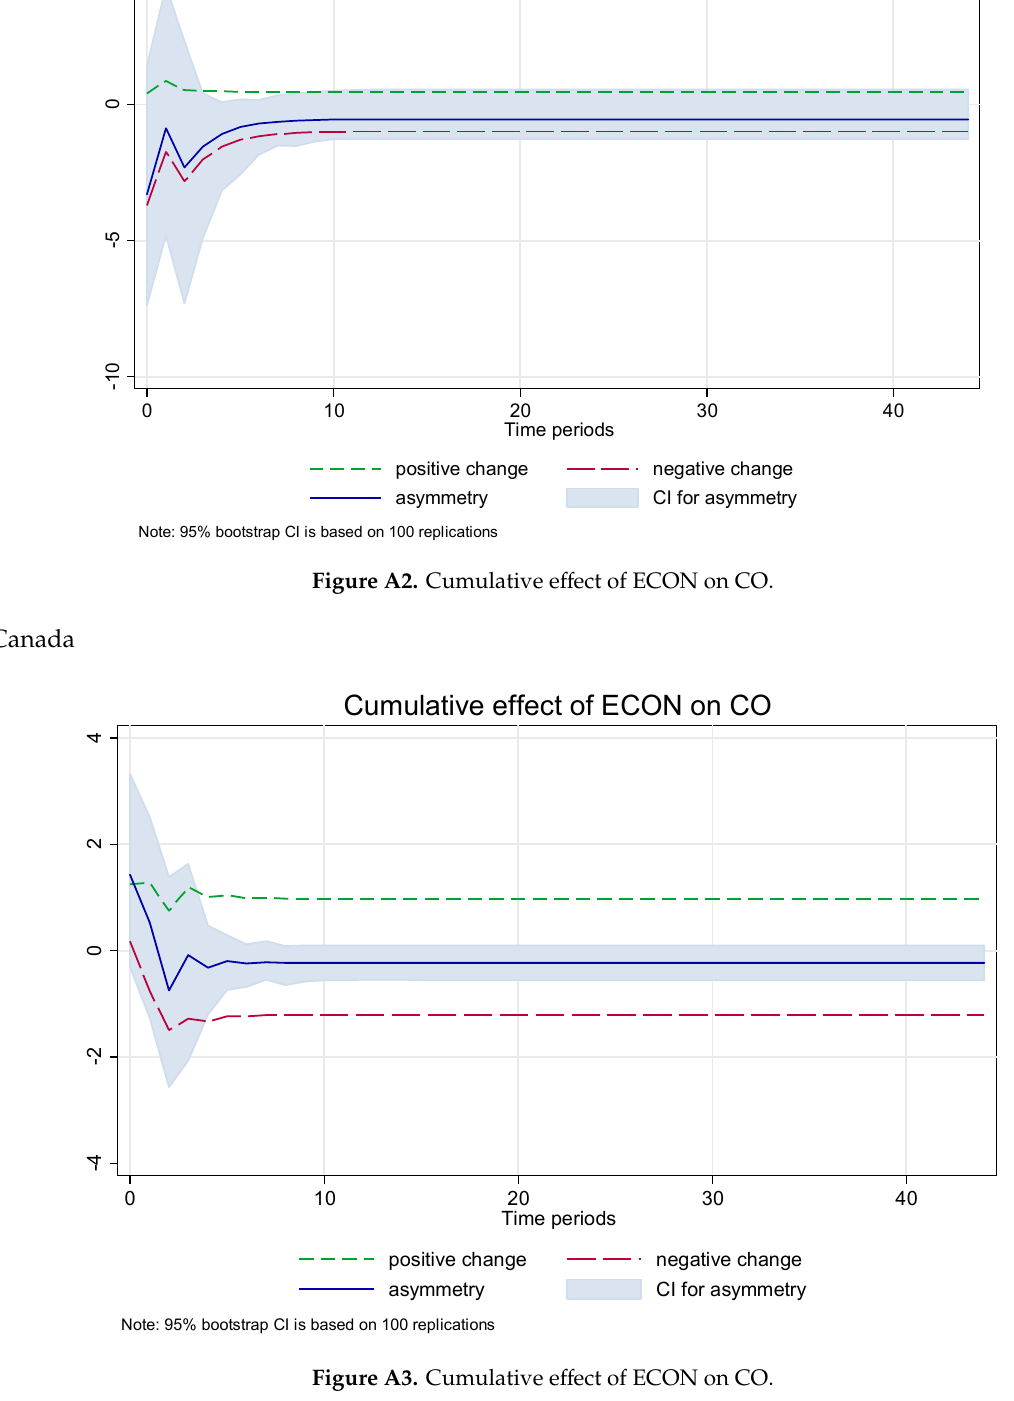
Figure A3. Cumulative effect of ECON on CO.